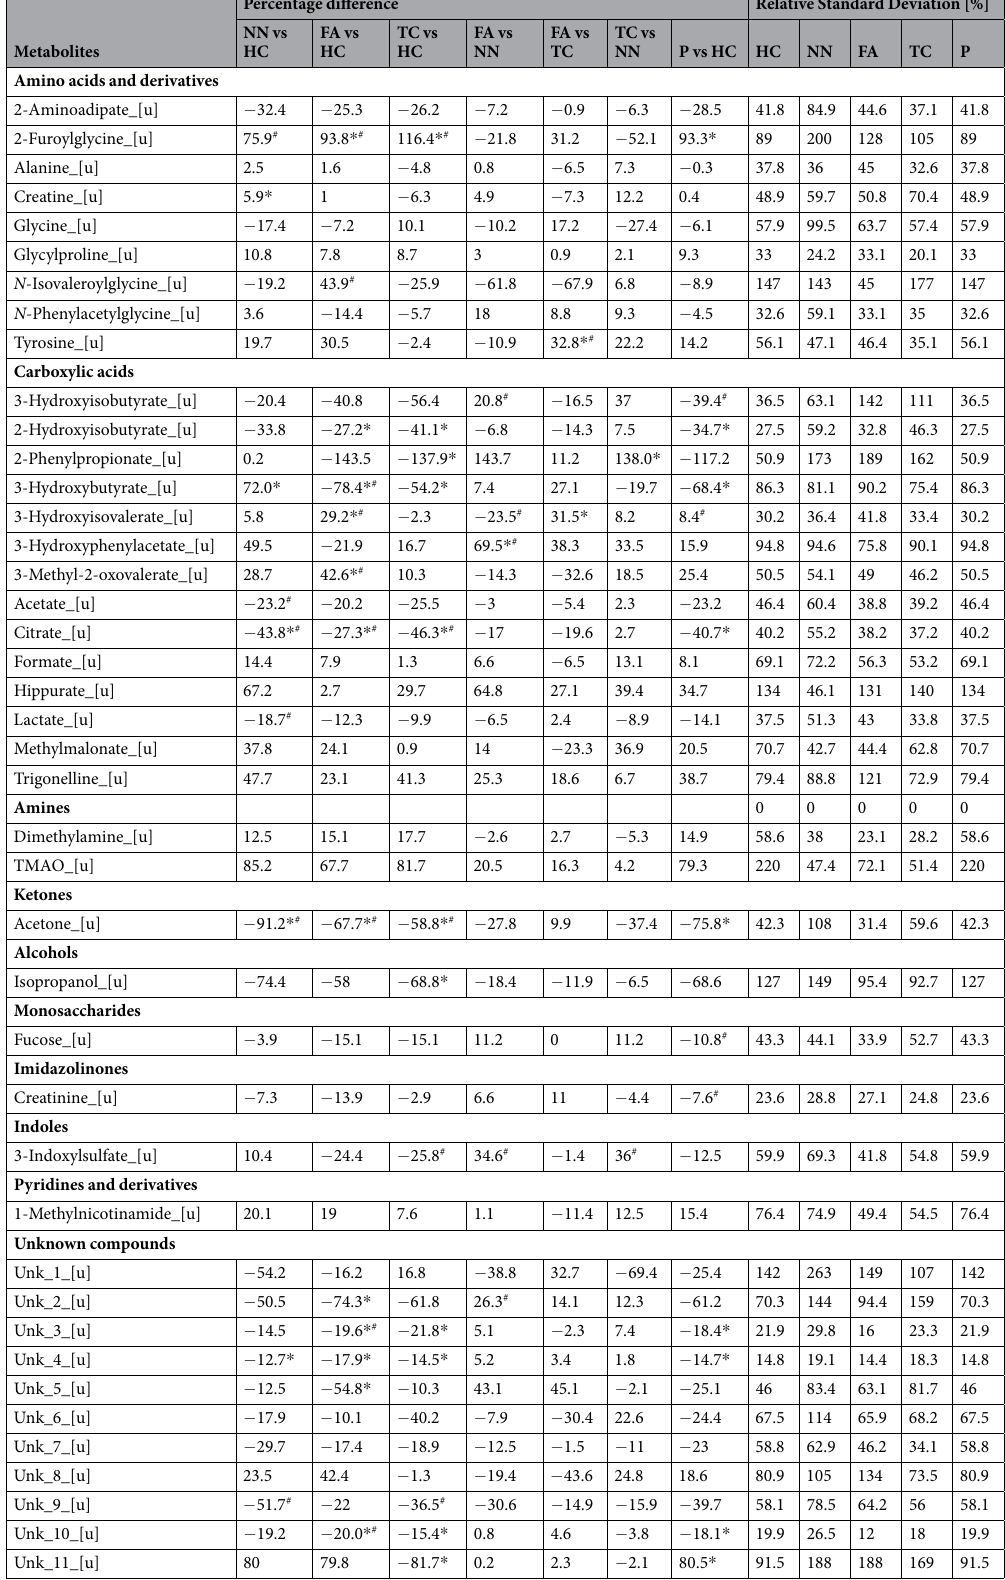
Table 4. Significantly changed urine metabolites ( # - VIP plot selected metabolites; * - statistically significant